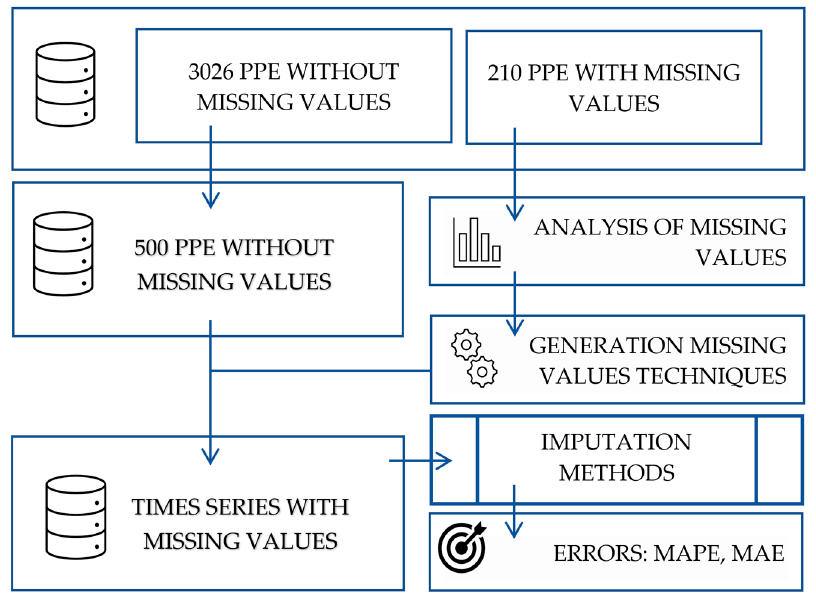
Figure 5. The procedure for selecting the method of the imputation of missing data. Source: own elaboration.